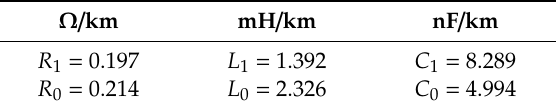
Figure 4. Transmission tower dimensions.